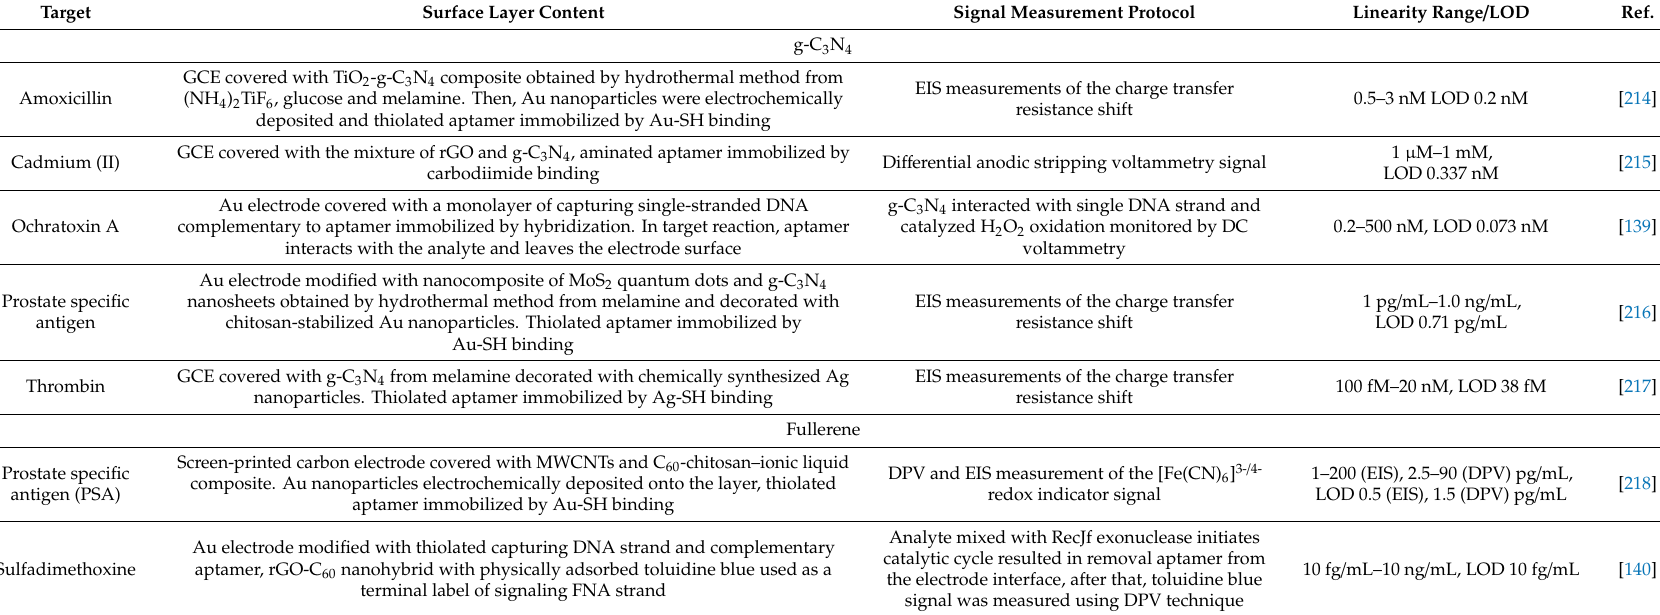
Table 3. Characteristics of electrochemical aptasensors based on other carbon nanomaterials